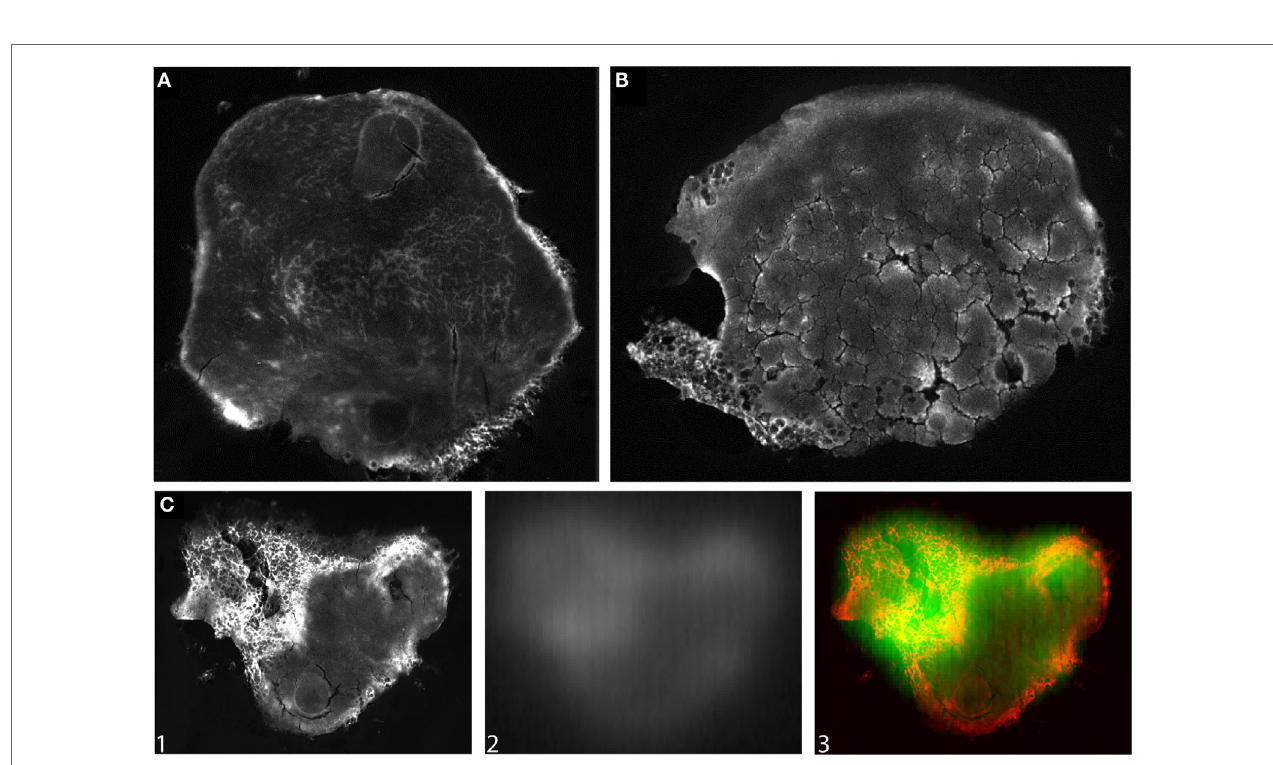
FigUre 7 | Ex vivo fluorescence and autoradiography images of tumors . Representative images of (a) control and (B) irradiated tumor resected 40 h following injection of [ 111 In]DTPA-HQ4. The tumors were imaged for HQ4-DTPA fluorescence. (c) Overlay (C3) of HQ4-DTPA fluorescence (C1-red) and 111 InCl 3 radioactivity (C2-green) in a tumor, illustrating co-localization of the two